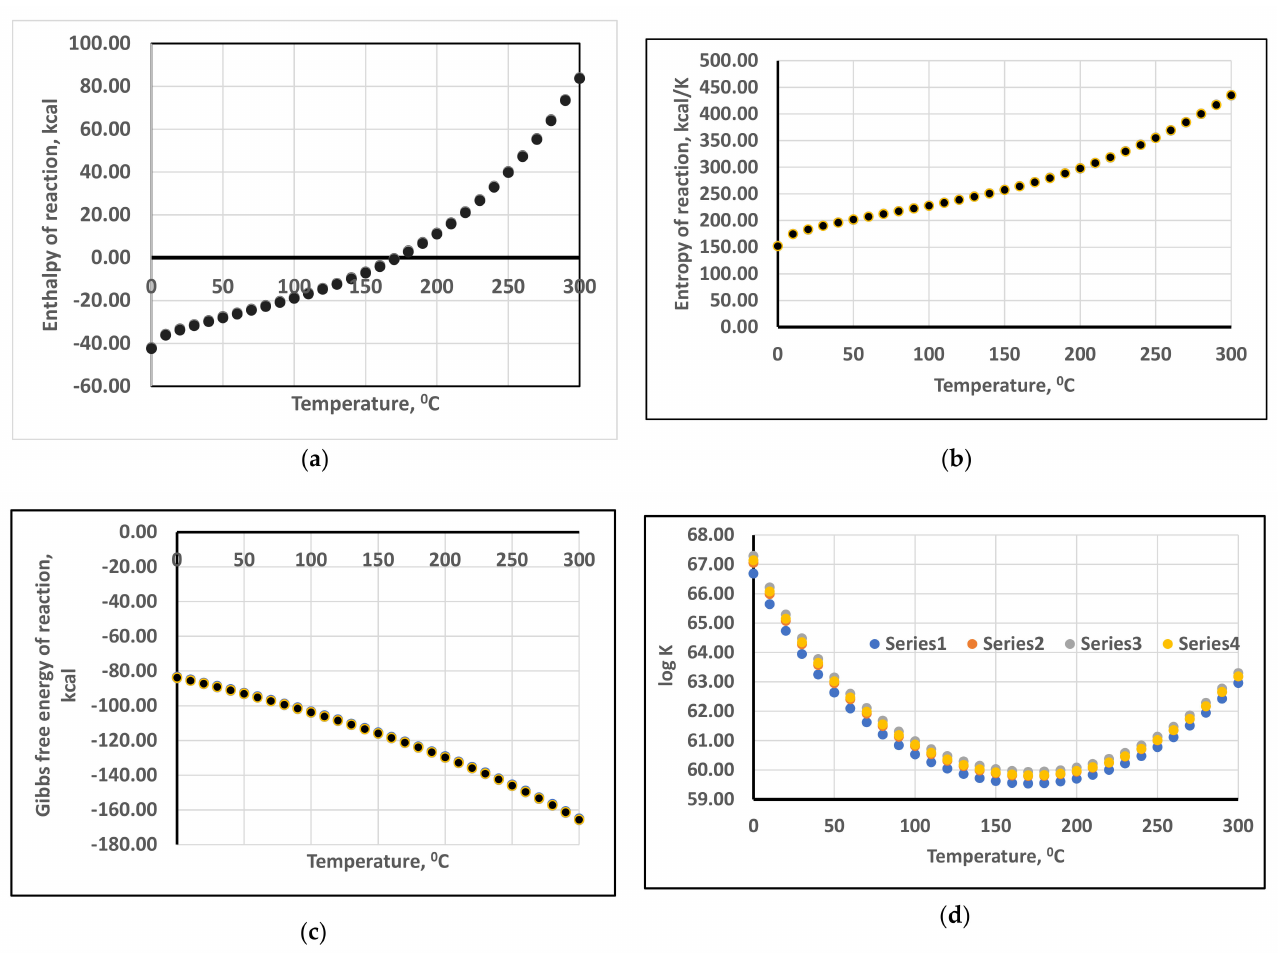
Figure 1. ( a ) Enthalpies of reactions (1), ( b ) entropies of reactions (1), ( c ) Gibbs free energy of reactions (1), ( d ) equilibrium constants of reactions (1). Series 1 corresponds to La 3+ , series 2 to Nd 3+ , series 3 to Sm 3+ and series 4 to Gd 3+